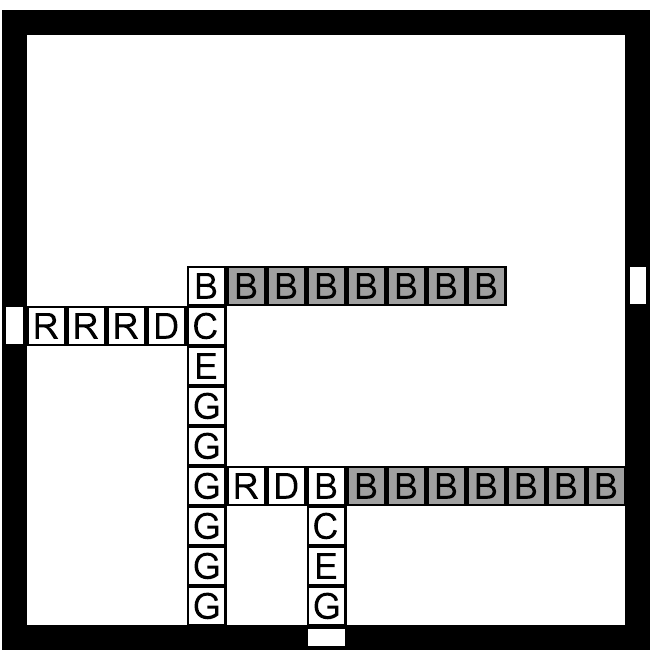
Fig 5. The RGB assembler running in (noncooperative) experimental conditions can produce a variety of error patterns, both before and after the designed point of cooperation. Either the red, green, or blue signal may set the radius (the size of the pattern.) Here, both signals attempt to fake cooperation by nondeterministically attaching a cooperation tile and spawning erroneous color signals. Each possible red and green signal may do so, producing a large quantity of error patterns.